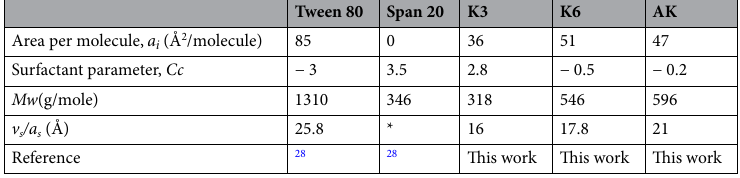
Tween 80 Span 20